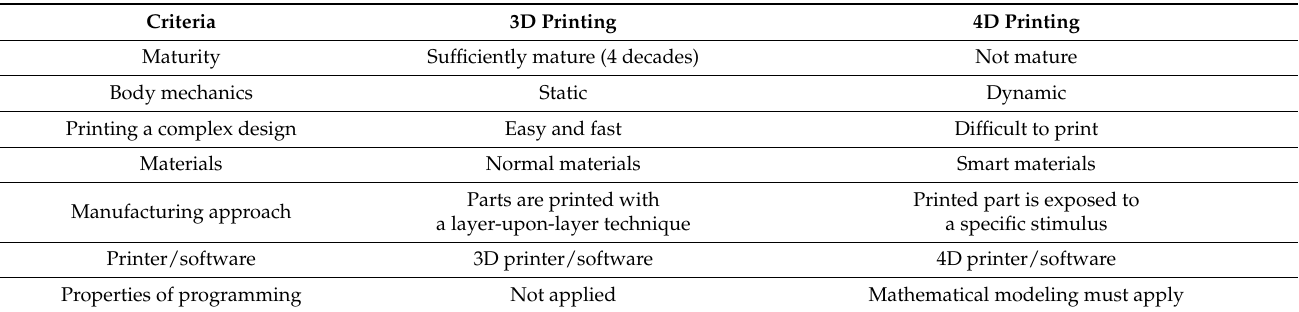
Table 2. Comparison of 3D Printing and 4D